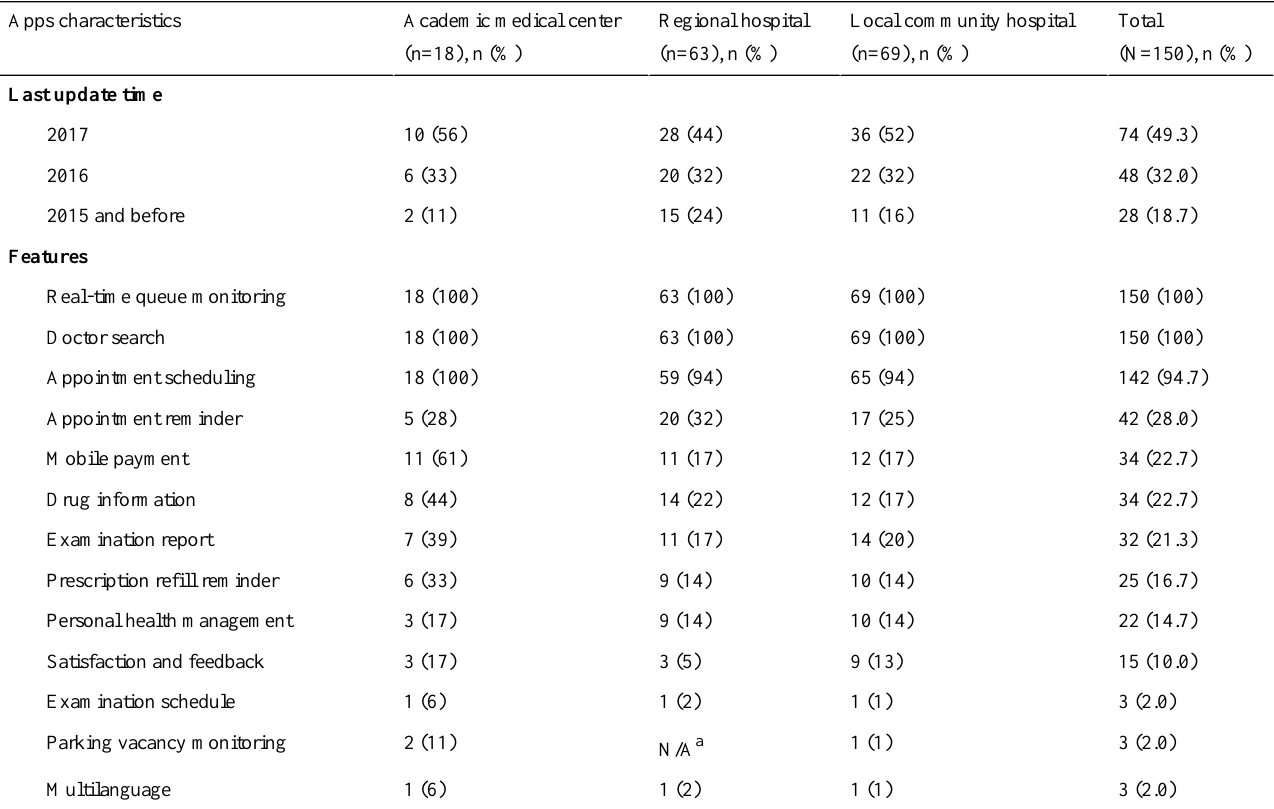
a Values are hospitals with apps/all hospitals (percentages) unless otherwise indicated. b N/A: not applicable. Table 2. Content and features of hospital-owned apps